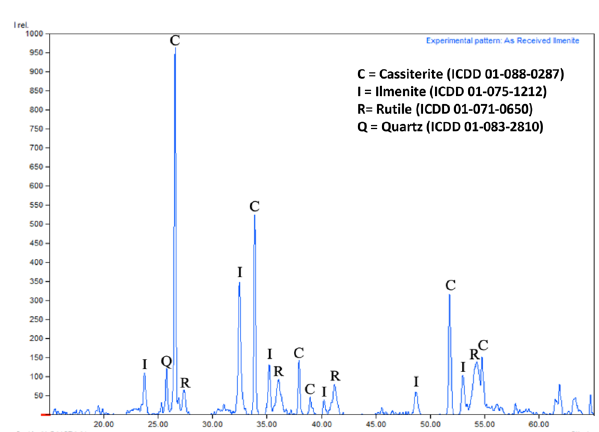
Figure 1. XRD patterns of the ilmenite sample.